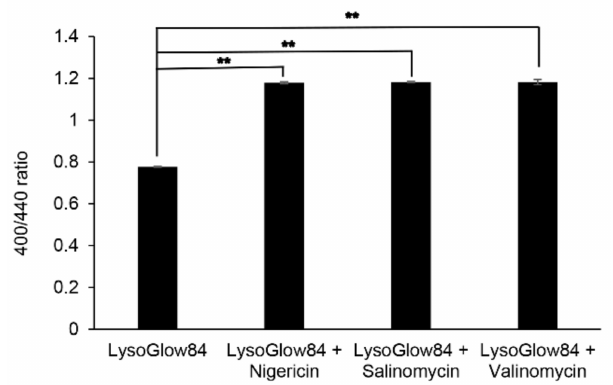
Figure 5. Ionophore antibiotics affect the pH of endosomes. LysoGlow84 (10 µ M) with each antibiotic of salinomycin, valinomycin, and nigericin (12.5 µ M, 25 µ M, and 6.3 µ M, respectively) at maximal concentrations without cell toxicities was added to the Felis catus whole fetus-4 cells. Fluorescence spectra were measured at 315 nm (excitation) and 360–560 nm (emission) using a spectrophotometer. The alkaline range from pH 8 to 13 showed fluorescence intensity at 400 nm emission, and those of the acidic range from pH 3 to 6 at 440 nm emission and at 315 nm excitation. Increasing the ratio of 400/440 indicates shifting to alkaline conditions. Error bars indicate standard deviations. Data were analyzed using one-way ANOVA with Dunnett’s multiple comparison test (** p <